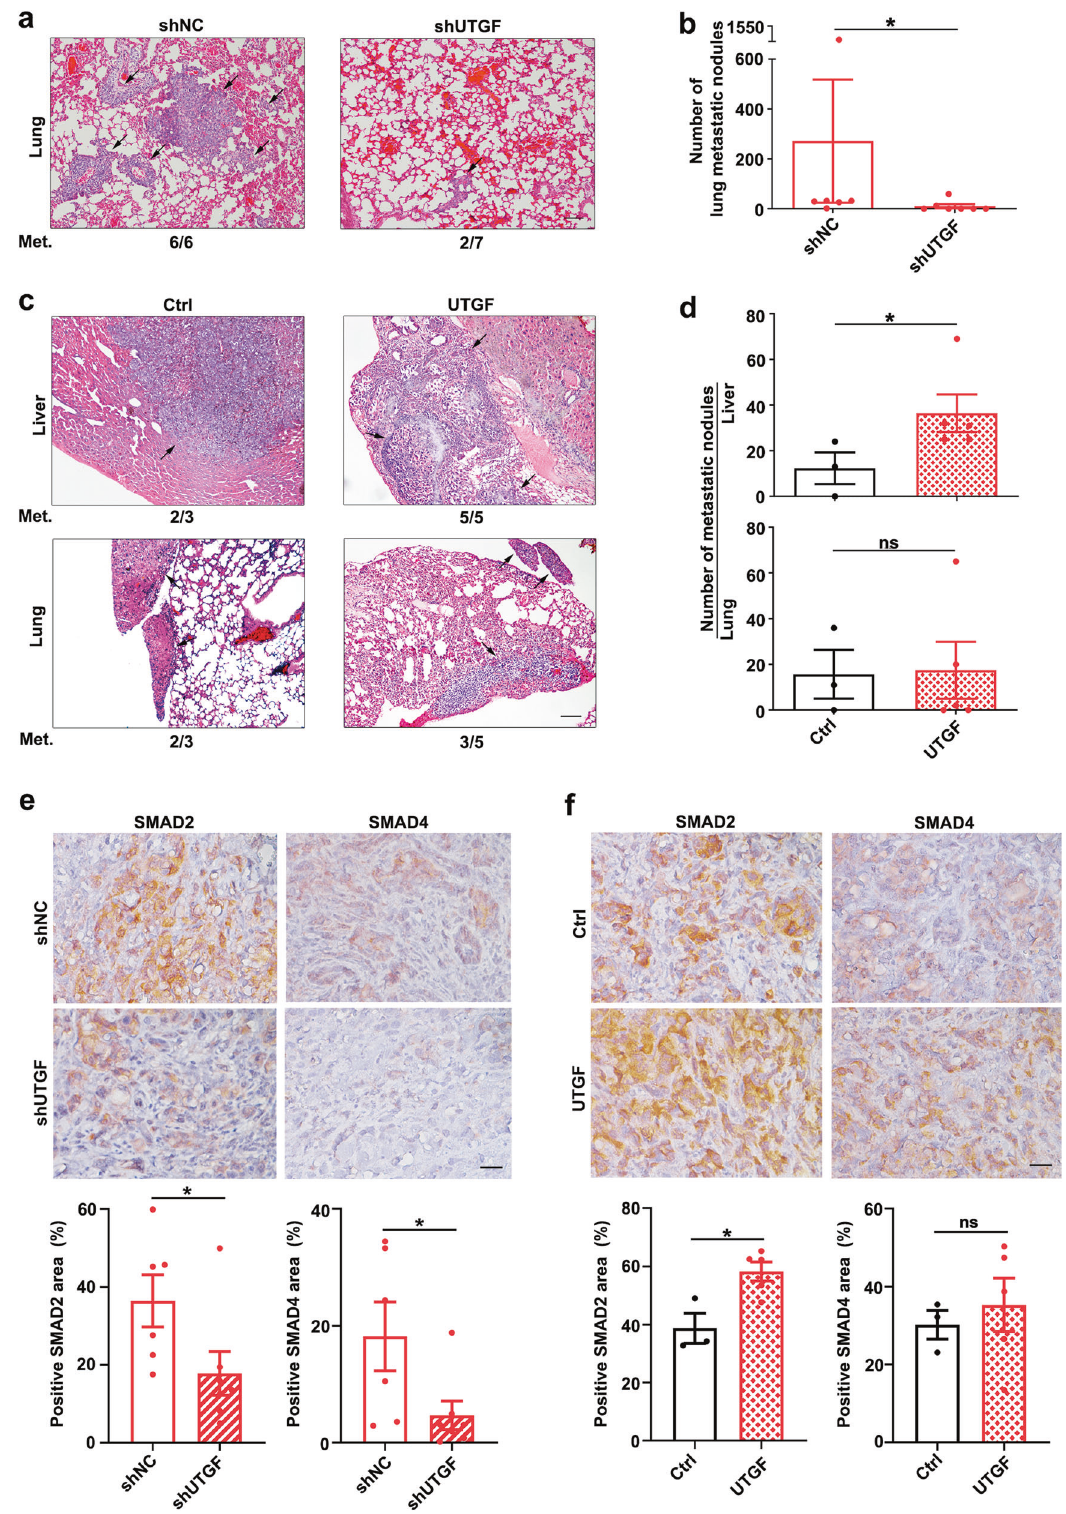
Rapid-ampli fi cation of cDNA ends (RACE) The 5 ′ - and 3 ′ -end of lnc-UTGF transcript was determined by the 5 ′ RACE (D315, TaKaRa, Kyoto, Japan) and 3 ′ RACE System (Version 2.0; Invitrogen, Carlsbad, CA, USA) respectively, using total RNA from normal liver tissues.